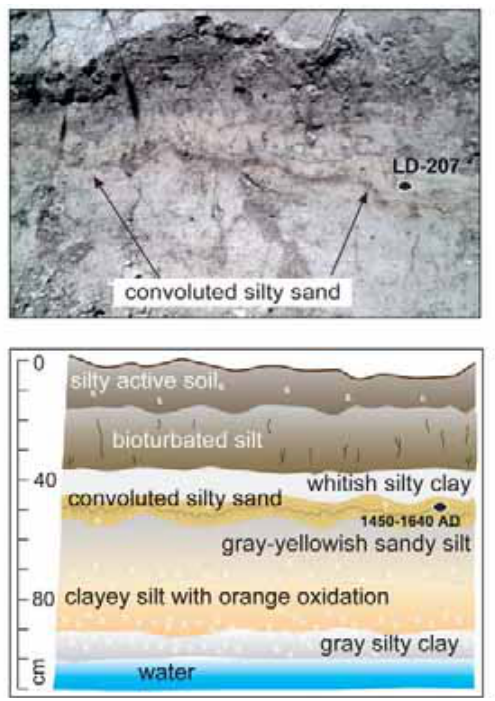
Fig. 7. Lesina Lake site: picture of the convoluted layer (above) and simplified sketch of the upper 1 m stratigraphy studied in the ditches (below). The lo- cation of one charcoal sample is also plotted with a black